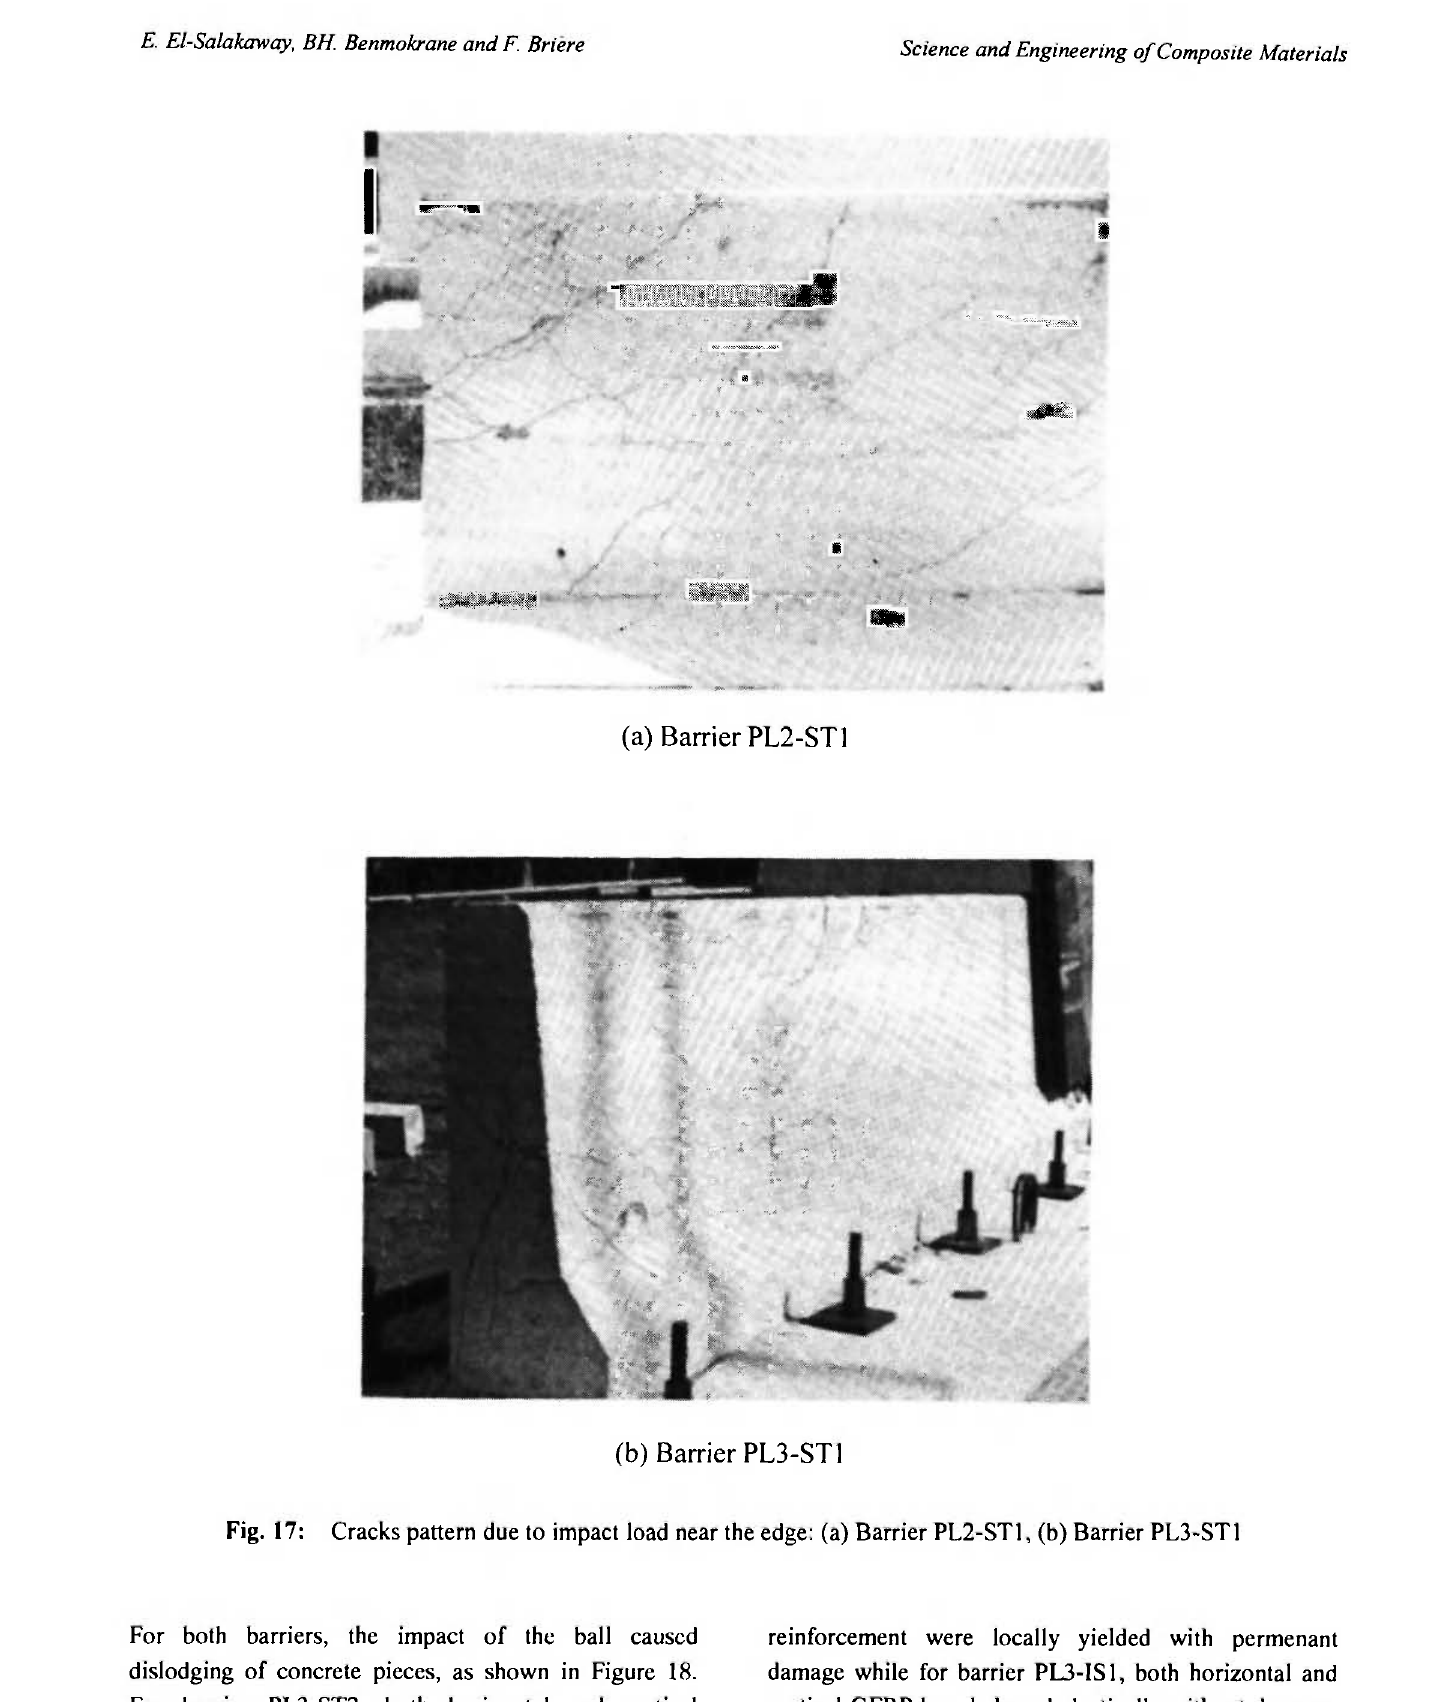
reinforcement were locally yielded with permenant damage while for barrier PL3-IS1, both horizontal and vertical GFRP bars behaved elastically without damage.